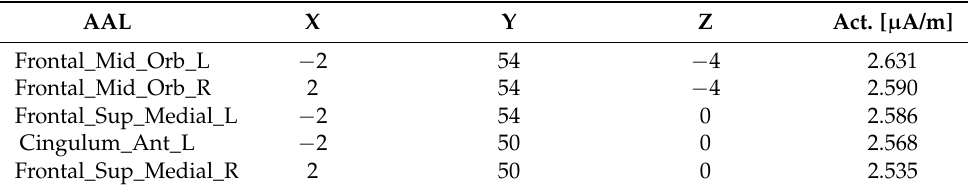
Figure 2. Mean electrical maps for Condition 1 (hearing participants, audiovisual stimulation). Maximal intensity projection areas are displayed in yellow/red color. SPMs were computed based on a voxel-by-voxel Hotelling T 2 test against zero. Table 2. Condition 1. Brain XYZ coordinates of the maximum in each of the activated